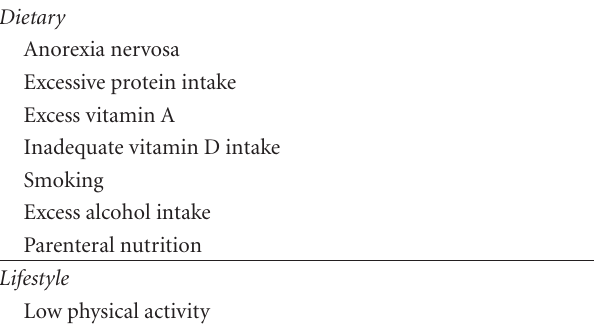
Table 1: Causes of secondary